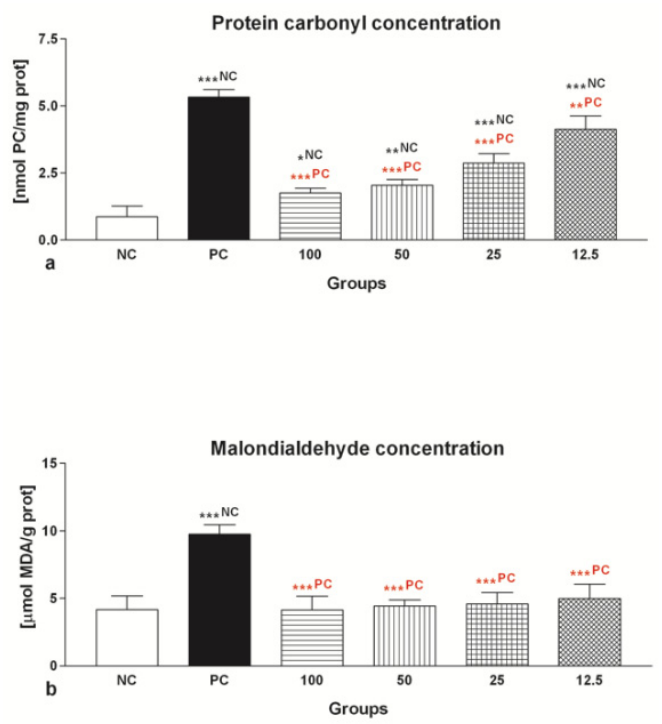
Figure 5. Oxidative damage to the proteins ( a ) and lipids ( b ) of bovine spermatozoa exposed to four doses of epicatechin (EPI; µ mol / L) in the presence of ferrous ascorbate (FeAA). A—The data were obtained from five independent experiments. * p < 0.05; ** p < 0.01; *** p < 0.001. NC—vs. negative control; PC—vs. positive control.